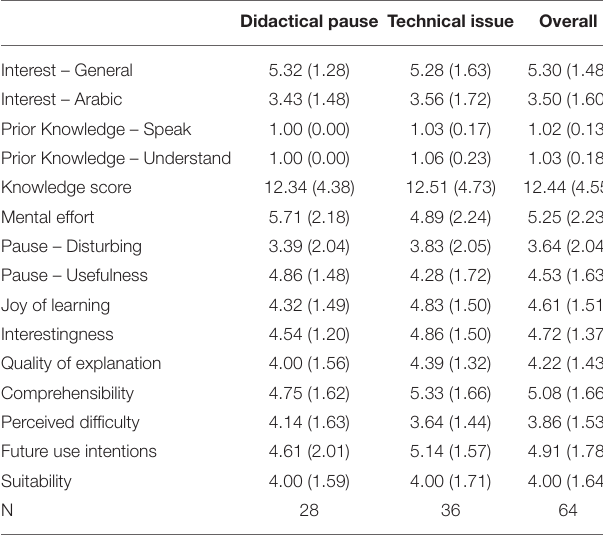
TABLE 1 | Means (and standard deviation) for the variables assessed in the